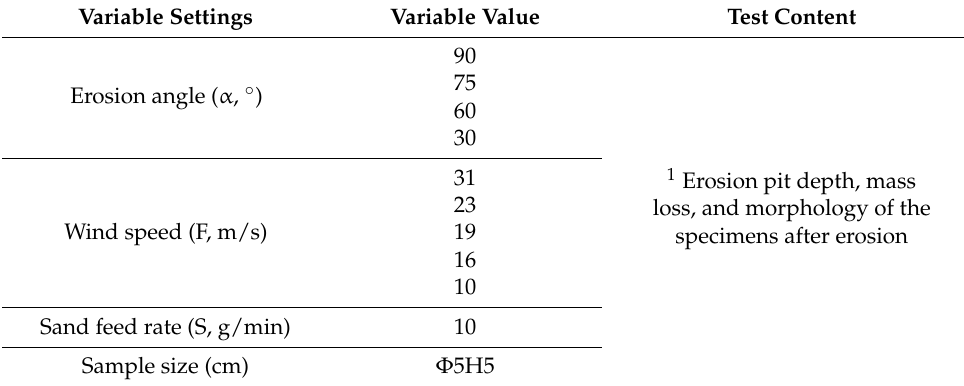
Table 6. Wind erosion test program.